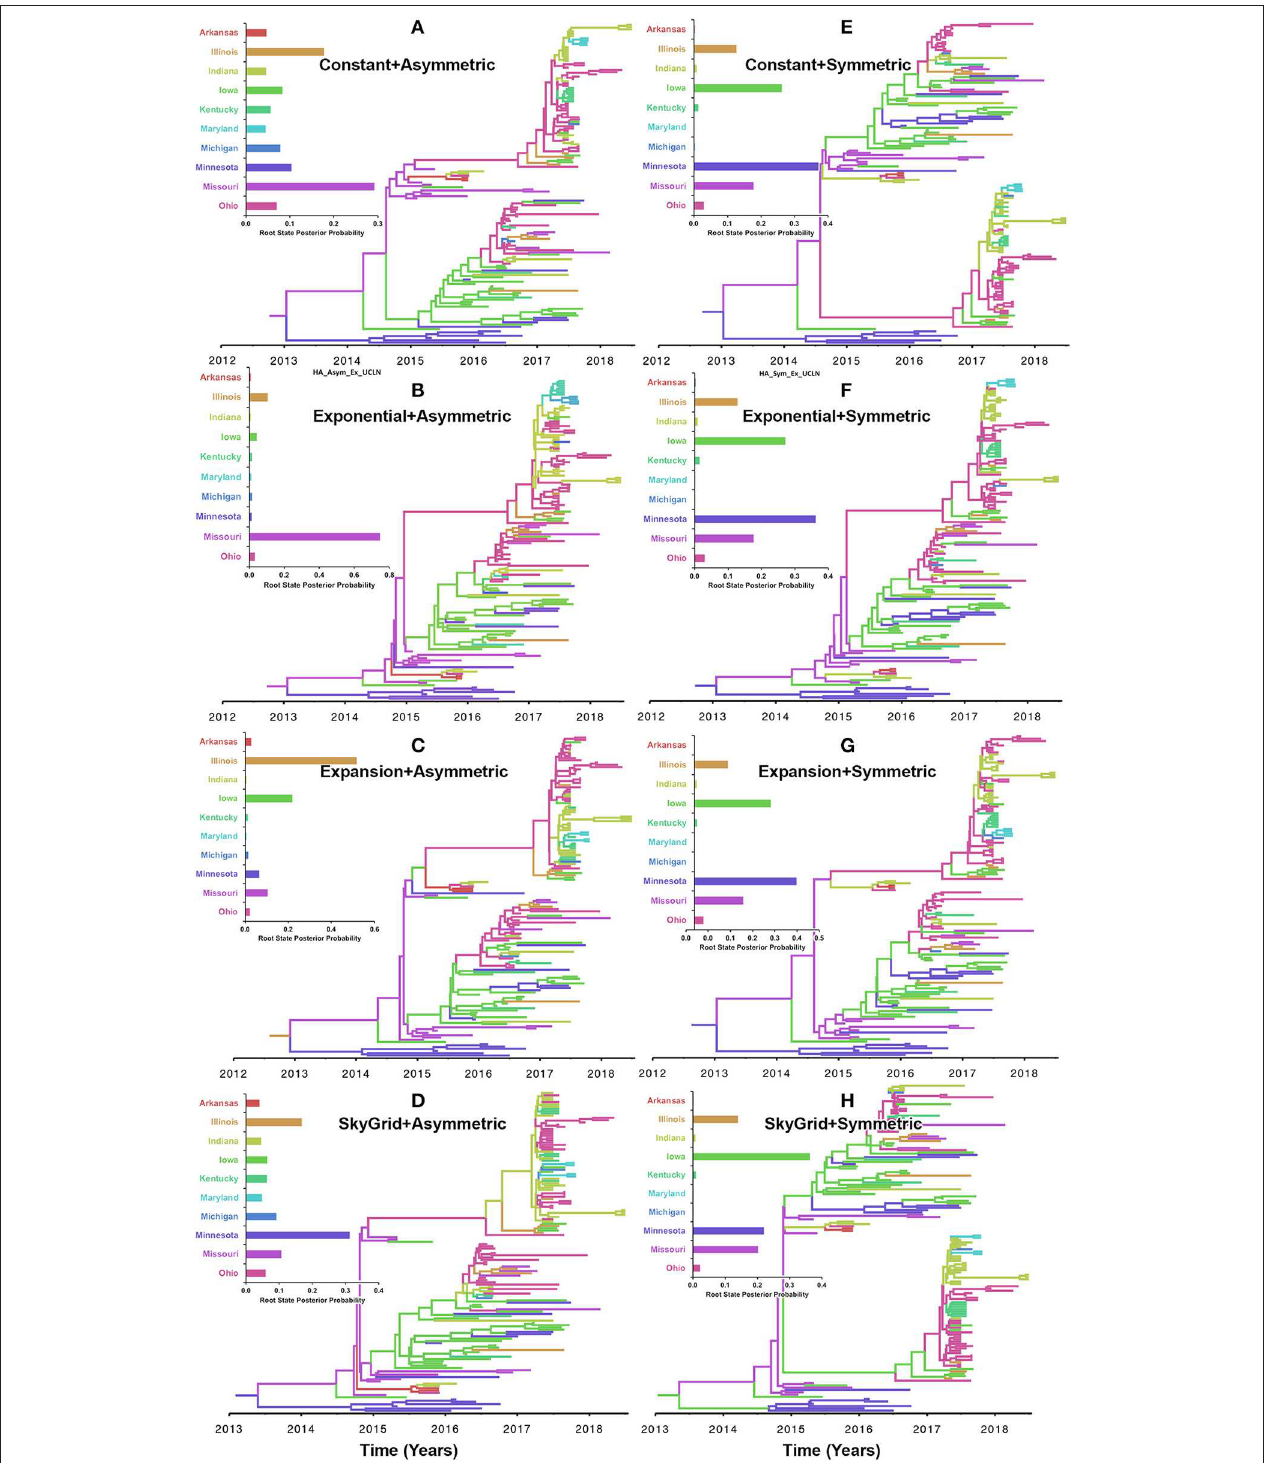
FIGURE 5 | Maximum clade credibility (MCC) phylogeny of the HA segment of human-like H3 swine influenza virus collected between January 2015 and June 2018 in the United States. The trees are inferred from eight phylodynamic model combinations (node-age and BSSVS priors). The color of the branches represents the most probable location state of their descendant nodes, and their color-coding corresponds to the upper left bar chart, which represents the root location state posterior probabilities (RSPP) for each state. (A–D) Trees inferred from four node-age + asymmetric BSSVS priors. (E–H) Trees inferred from four node-age + symmetric BSSVS